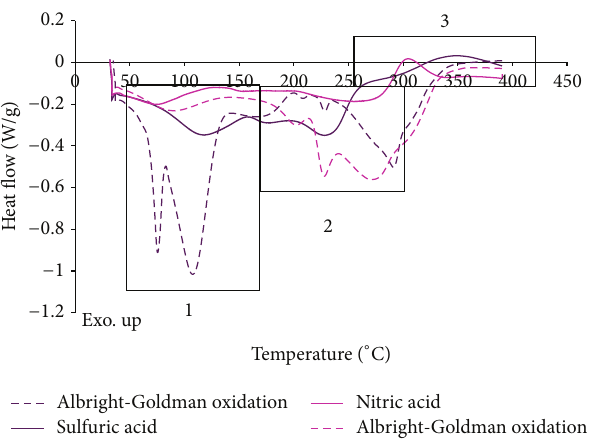
Figure 8: Modulated differential scanning calorimetry of function- alized and hydrolyzed cellulose extracted from wheat